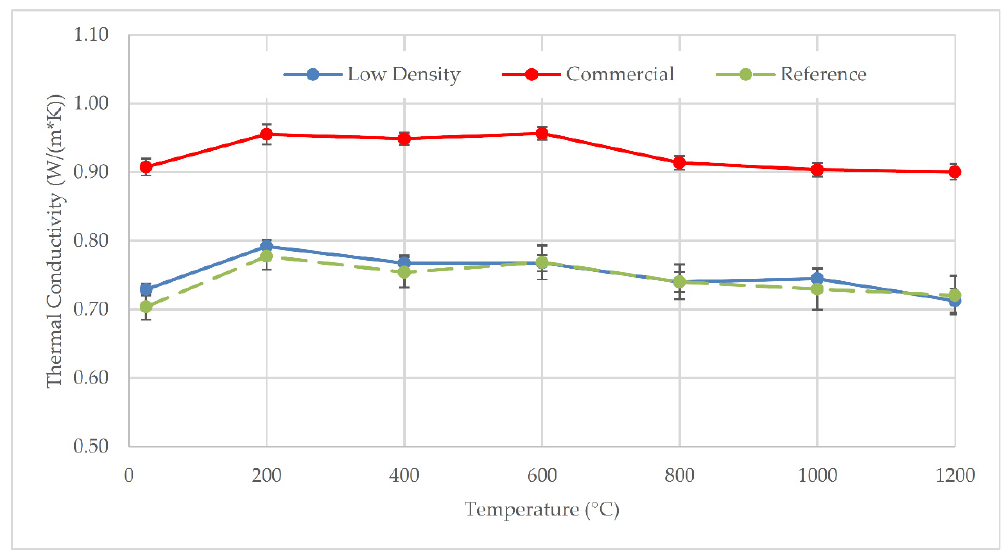
Figure 11. Thermal conductivity of coatings after furnace cyclic fatigue failure.